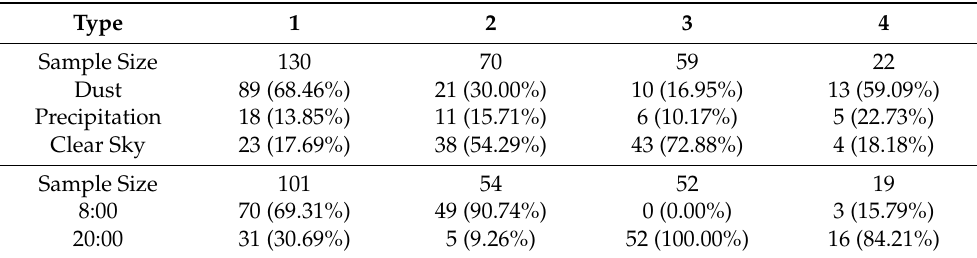
Table 3. PBLH inversion results of CDWL and GTS soundings by weather conditions and time of the day when divided into four